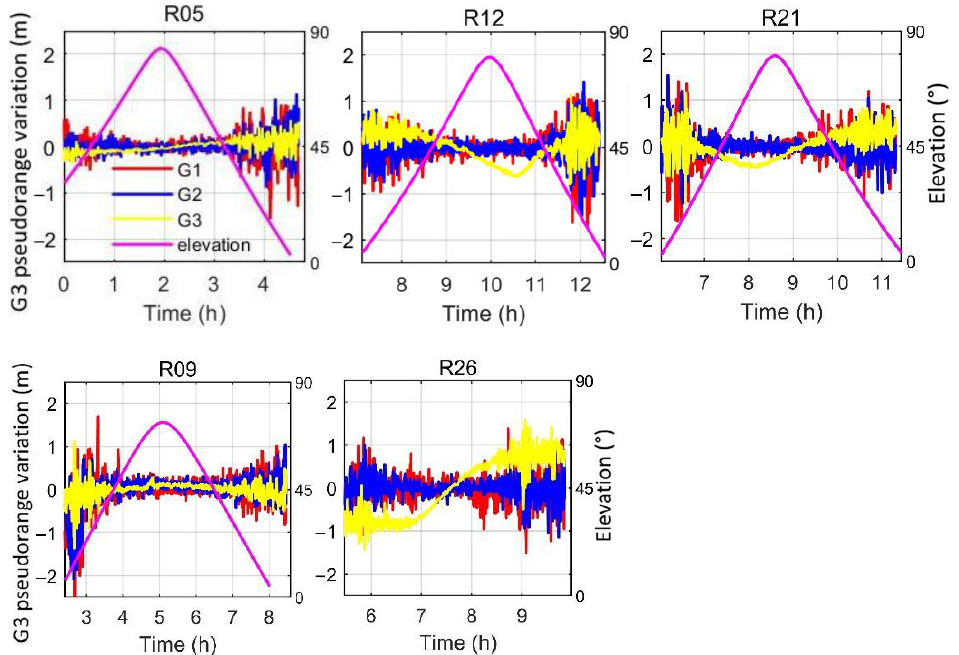
Figure 2. The relationship between the code pseudorange variations and elevation angle on DOY 325, 2020, at BRUX station. The red, blue, and yellow lines represent the code pseudorange variations on the G1, G2, and G3 frequencies, respectively. The purple line represents the elevation angle.